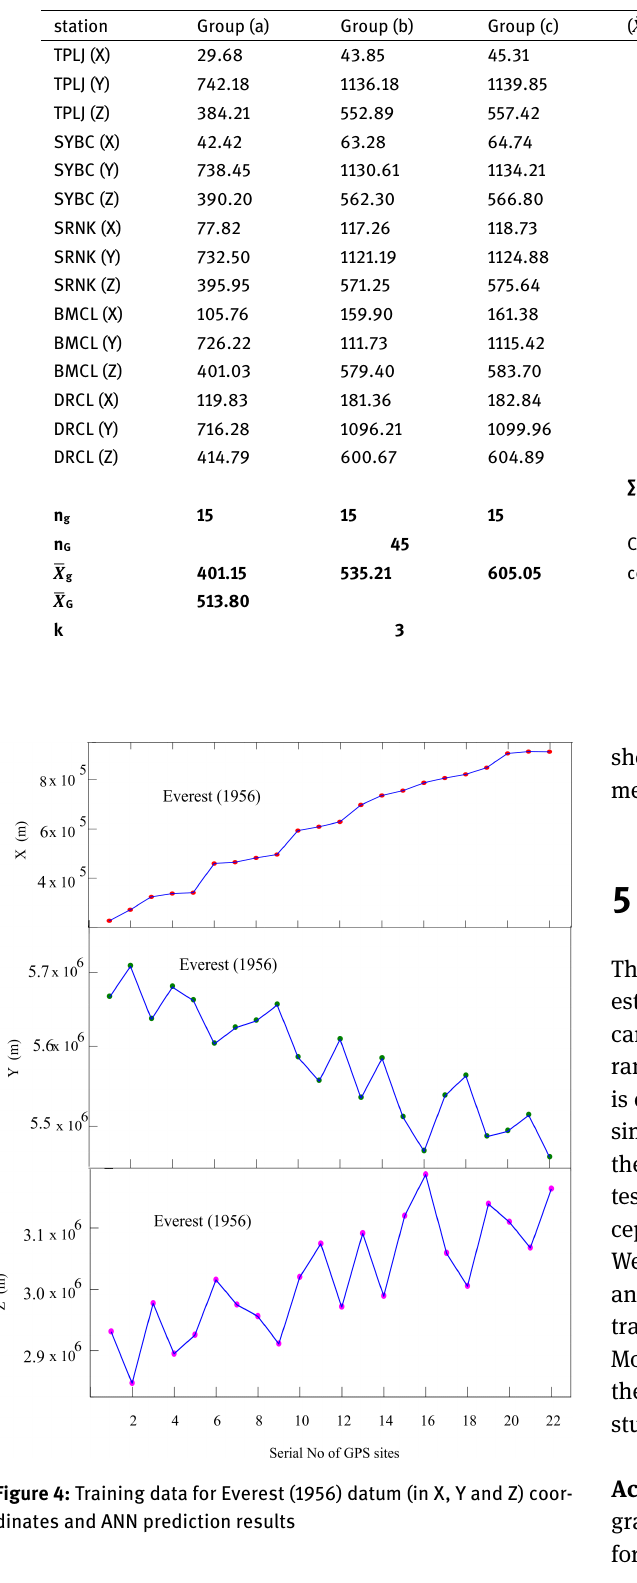
Table 3: ANOVA test for Everest (1956) datum